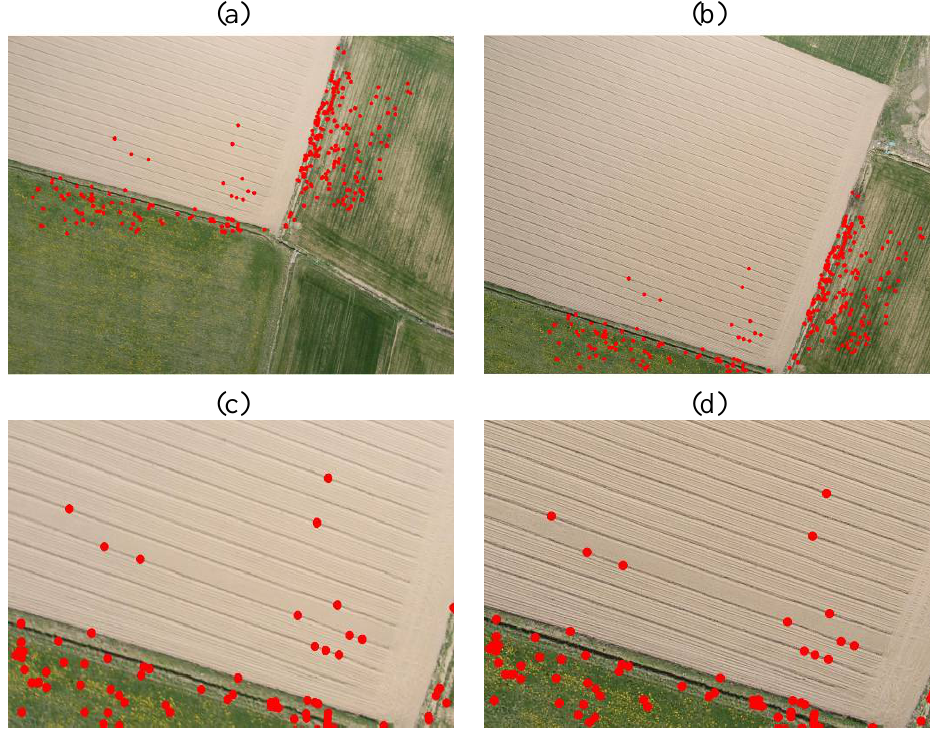
Figure 6. The Villareggia Test 2. (a), (b) The image correspondences automatically matched by SIFT (283 points,   xˆD = 0.01, L = 10). (c), (d) Details of the correspondences in the ploughed